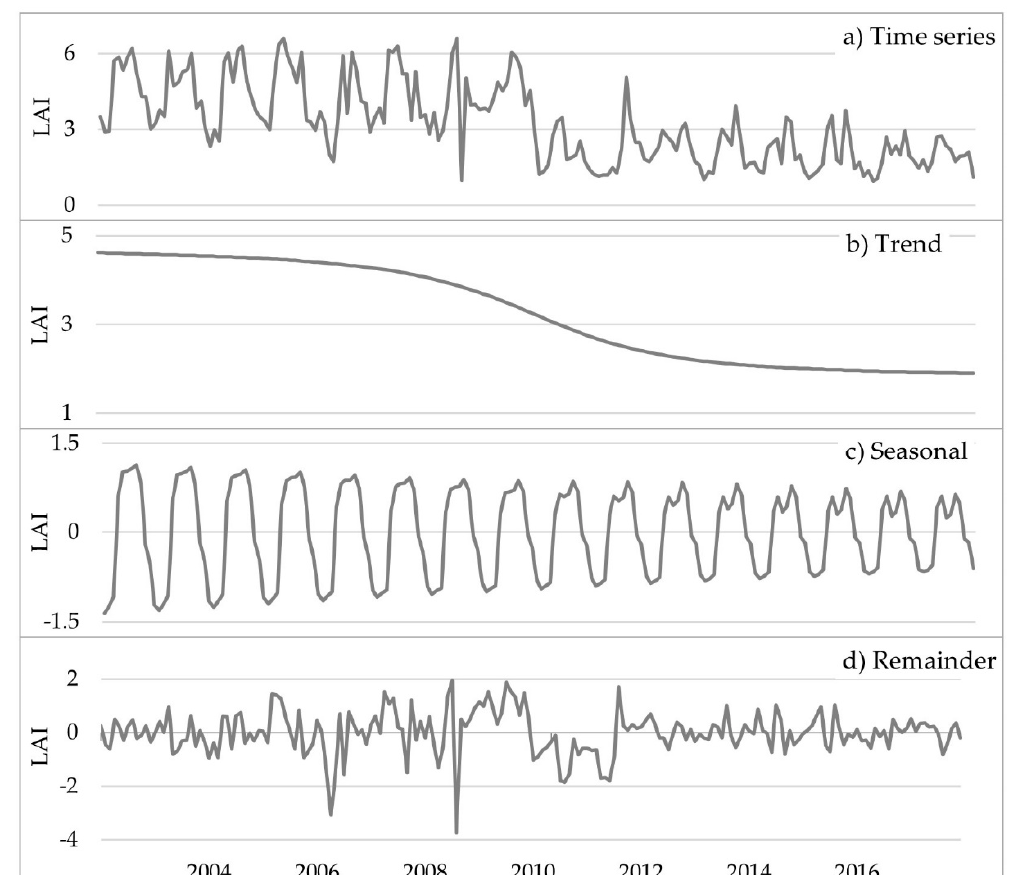
Figure 2. Example of the decomposition of a time series ( a ) into trend ( b ), seasonal ( c ), and reminder ( d ) components.